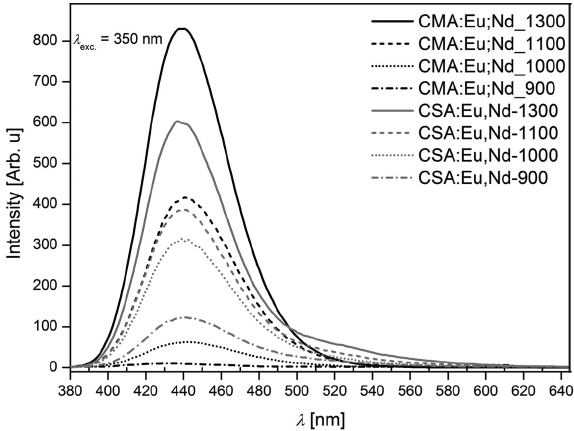
Figure 6. UV-excited ( λ = 350 nm) emission spectra of the exc. CMA:0.5Eu 2+ ,0.25Nd 3+ and CSA:0.5Eu 2+ ,0.25Nd 3+ samples